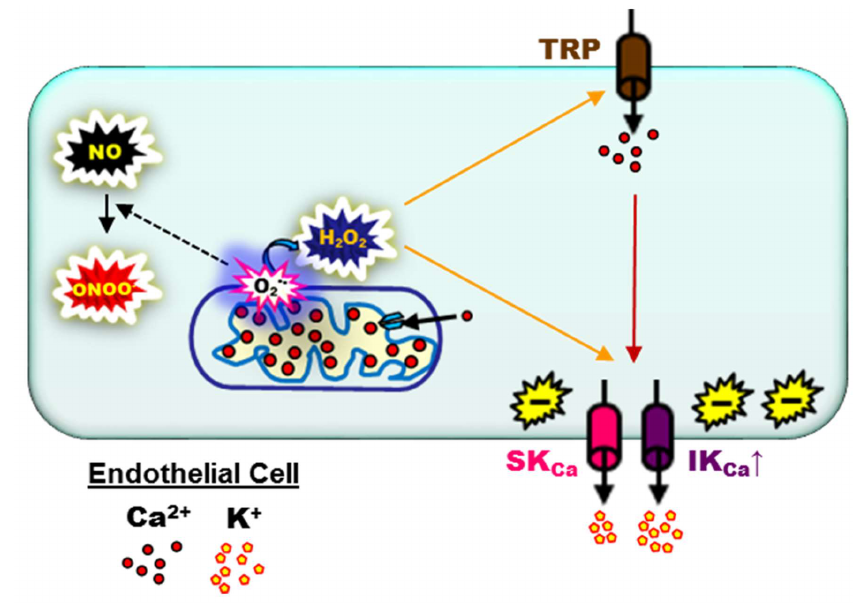
Figure 3. Working model for the upregulation of endothelium-derived hyperpolarization during aging and development of chronic pathology per enhanced oxidative signaling. Cardiovascular aging and the development of chronic disease is associated with a progressive increase in endothelial